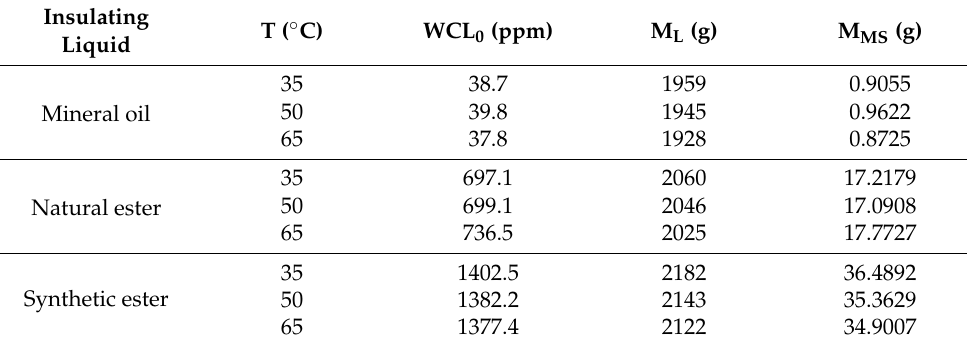
Table 2. Summary of the prepared samples.